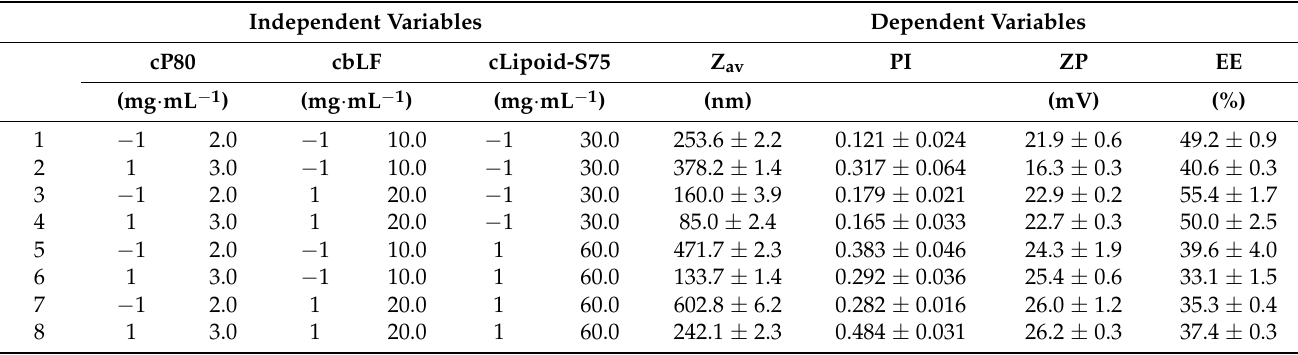
Table 1. Values of the 2 3+ star central composite rotatable factorial design, parameters and measured responses. Results presented as mean ± standard